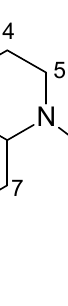
Figure 6. Structure of 2H1M